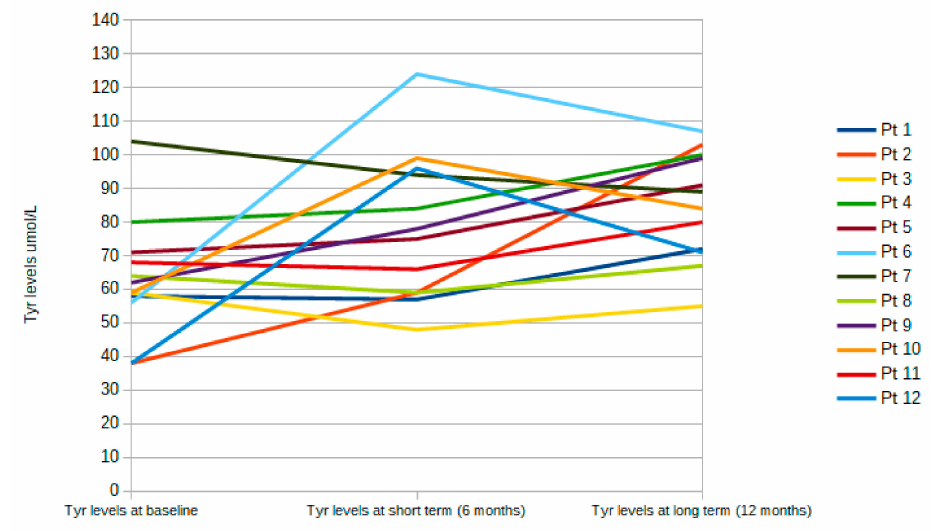
Figure 5. Tyr level at each time point: baseline, after 6 months (short term) and 12 months (long term) of LNAA treatment for each